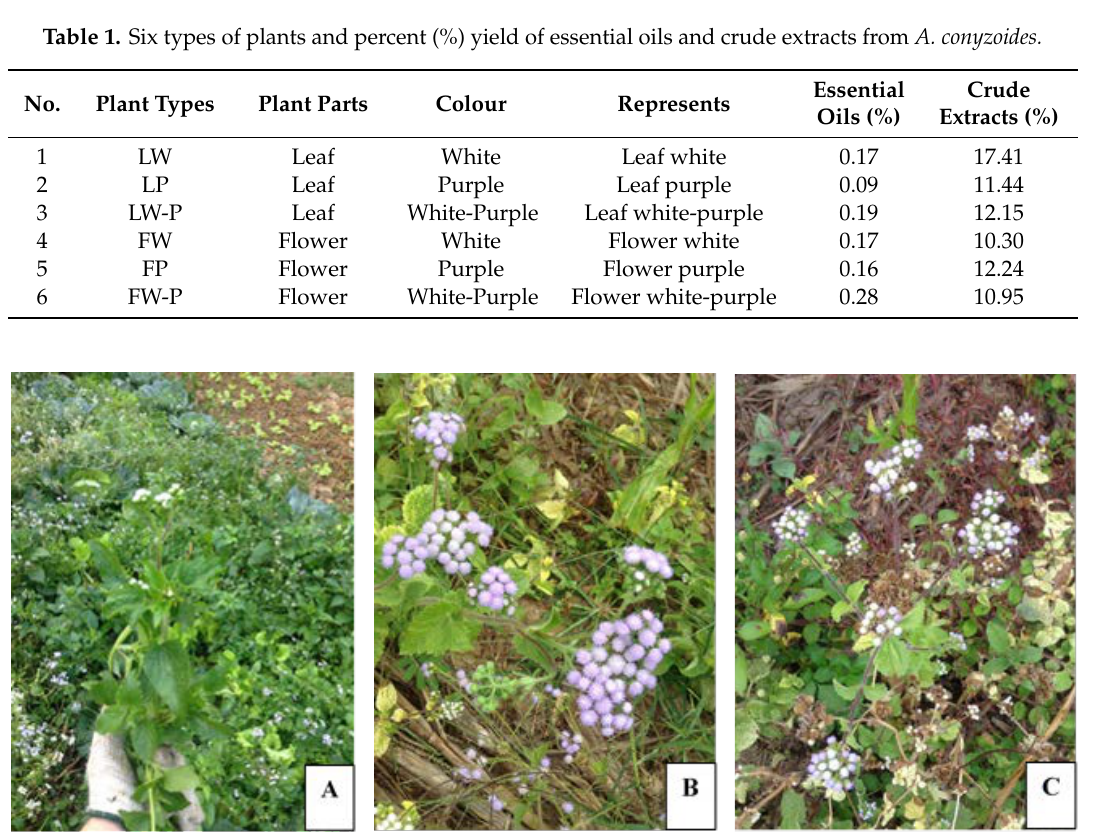
Figure 1. A. conyzoides weeds were collected from Chiang Rai province: white flower plant ( A ), purple flower plant ( B ), white-purple flower plant ( C ).